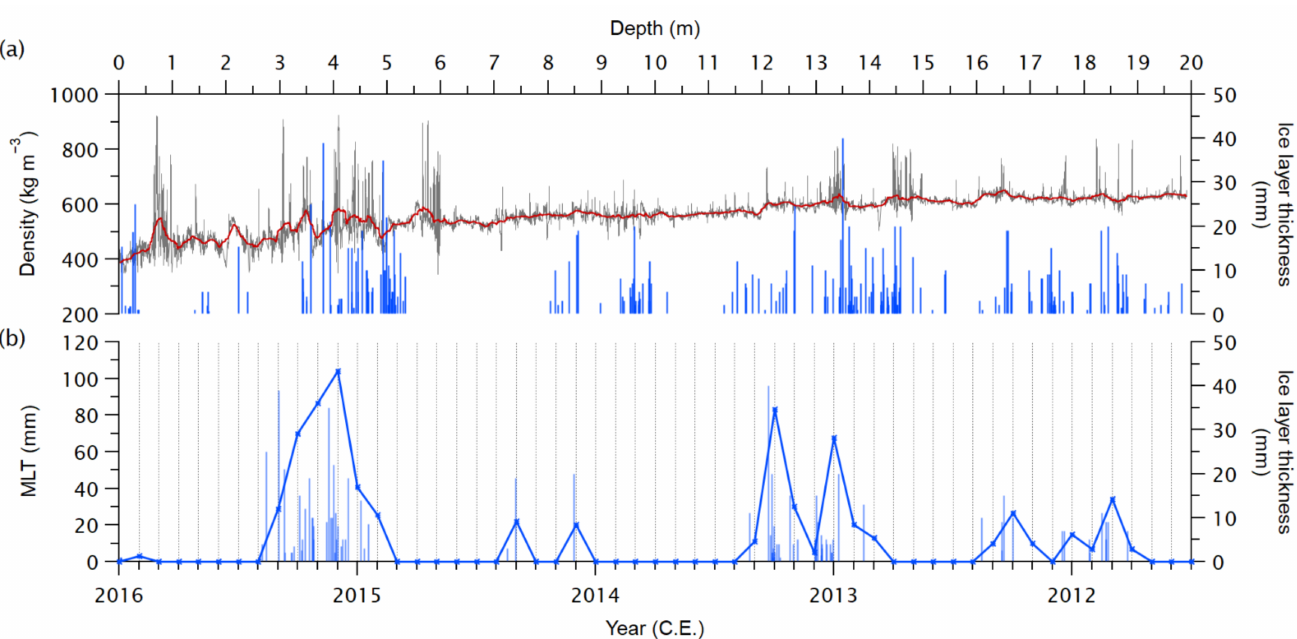
Figure 4. ( a ) Ice layer stratigraphy (blue lines) and high-resolution density–depth profile (grey; 1500-point running mean in red) of firn core OH-12. ( b ) Total monthly melt layer thickness (MLT; bold blue line) for the period covered by OH-12 calculated from ice layers indicating surface melt (light blue lines; details in the text) using the weighted age